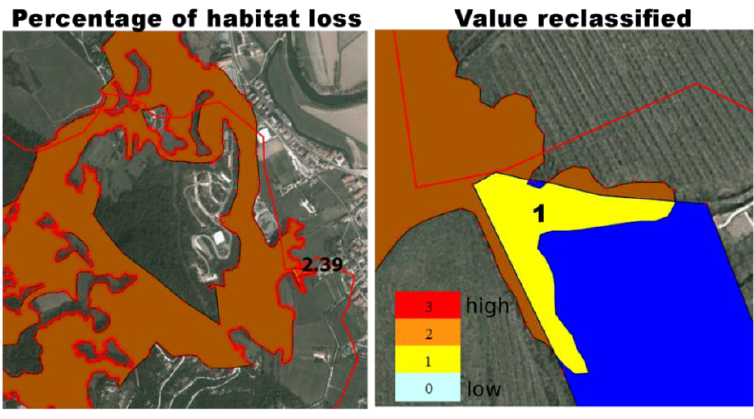
Figure 12. Reclassified value of influence as a result of habitat